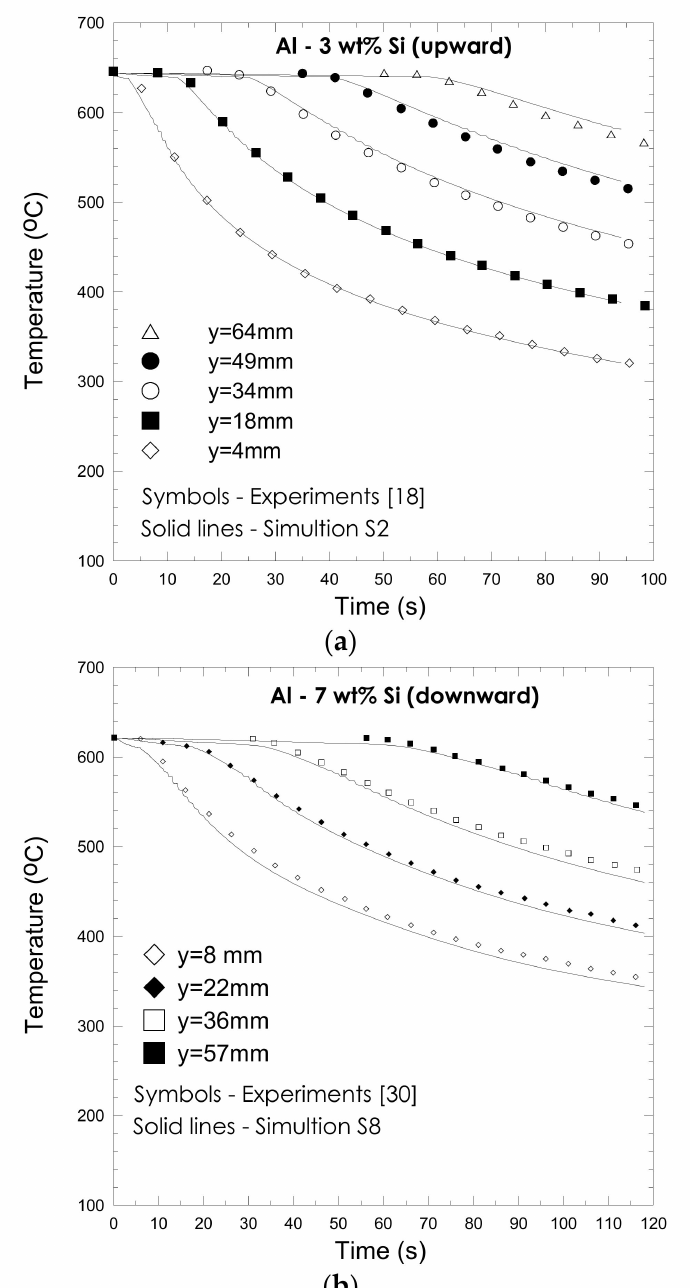
Figure 7. Experimental validation of transient temperature distributions at r = 0 with data from ( a ) Peres et al. [18] for upward solidification (with simulation S2) and ( b ) Spinelli et al. [30] for downward solidification (with simulation